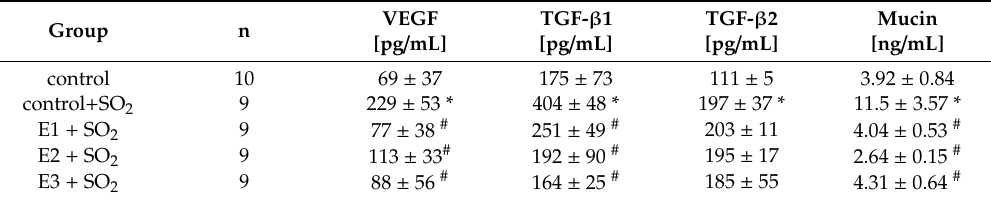
Table 3. Influence of different extracts from Platycodon grandiflorum A. DC on VEGF, TGF- β 1, TGF- β 2